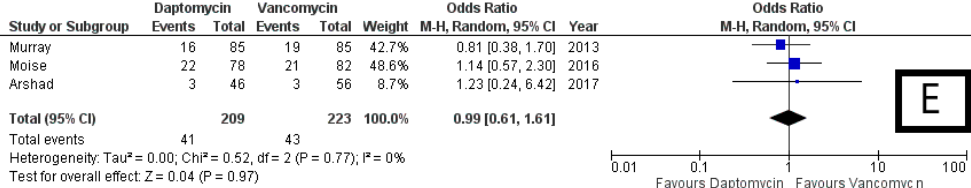
Figure 5. Forest plot depicting the odds ratio of recurrence ( A ) and BSI persistence ( B ), the mean difference in LOS ( C ), as well as the odds ratio of discontinuation due to safety issues ( D ) and 30-day readmission ( E ) of patients receiving daptomycin vs. vancomycin.